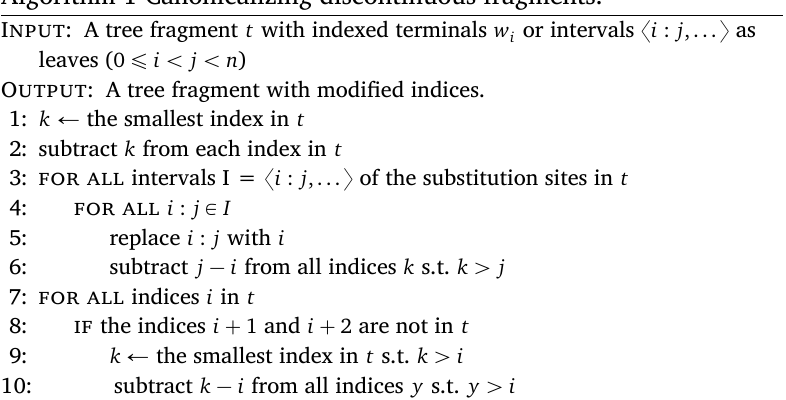
Canonicalization of fragments extracted from parse trees. These sample fragments have been extracted from the tree in Figure 1. The fragments are visualized here as discontinuous tree structures, but since the discontinuities are encoded in the indices of the yield, they can be represented in a standard bracketing format as used by the fragment